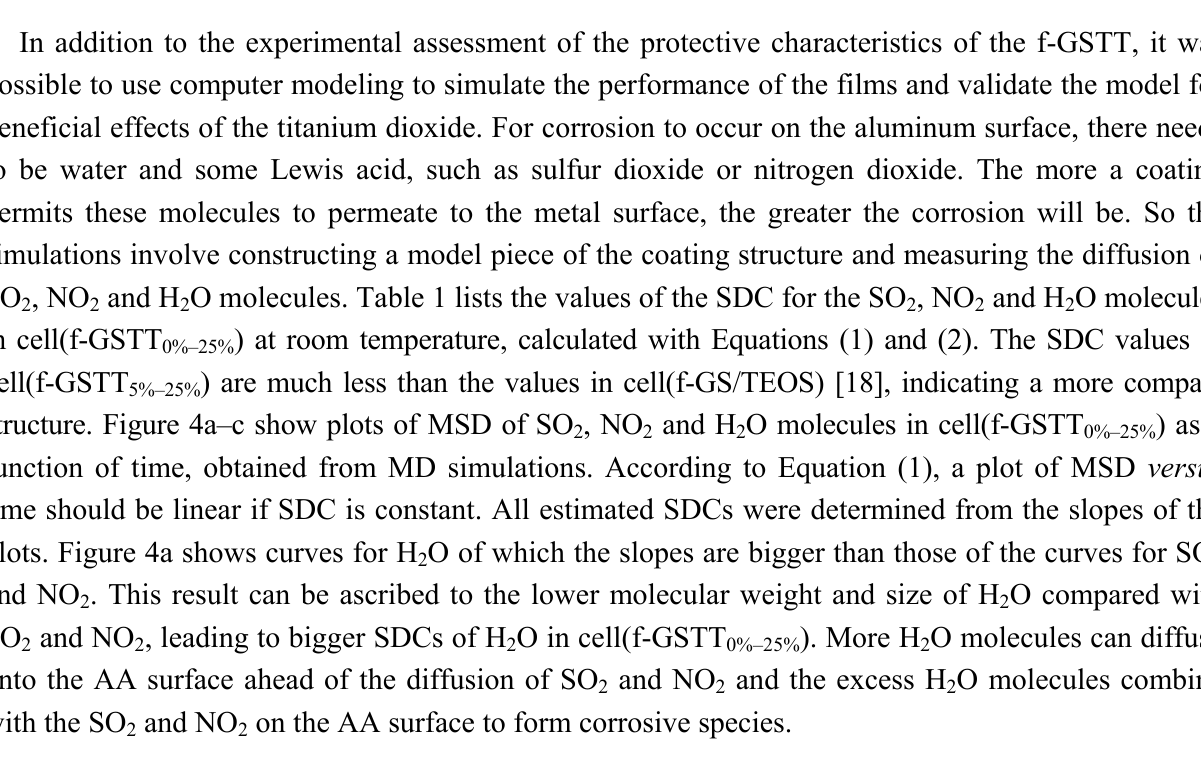
Table 1. Estimated self-diffusion coefficient (SDC) for SO cell(f-GSTT